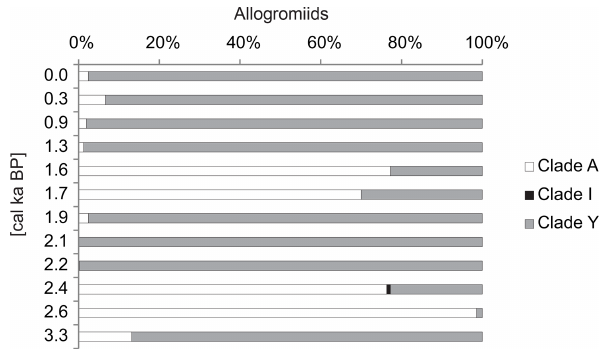
Figure 7. The percentage share of certain clades in the allogromiid